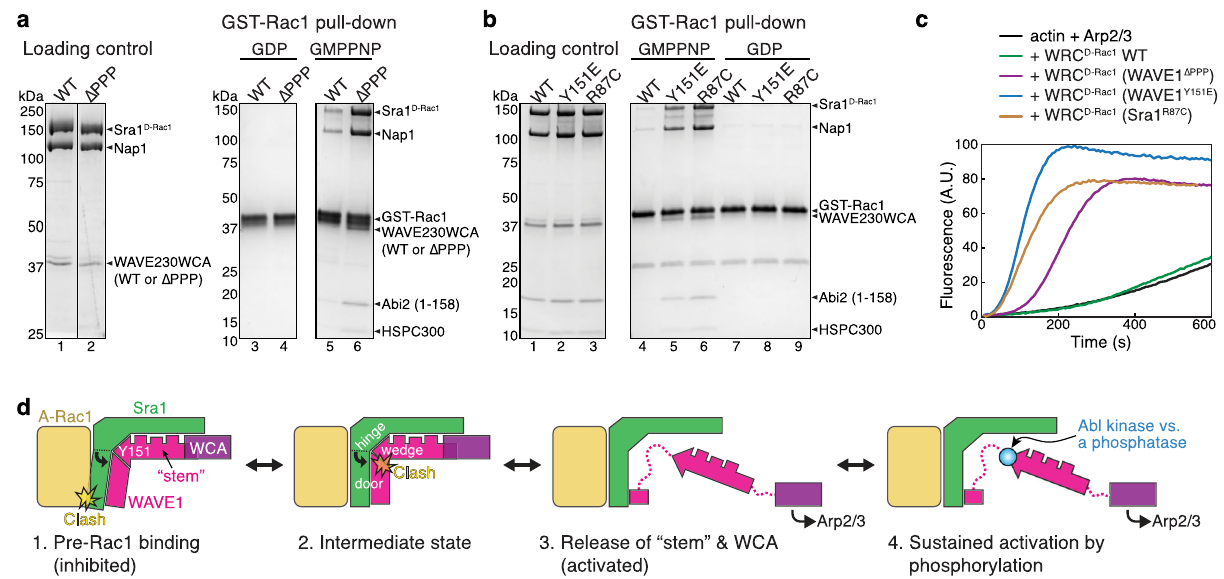
Fig. 5 | An allosteric competition model explains WRC activation by Rac1 binding to the A site. a , b Coomassie blue-stained SDS-PAGE gels showing GST- Rac1 P29S (loadedwithGDPorGMPPNP)pull-downofWRC D-Rac1 bearingtheindicated mutations: WAVE1 Δ PPP in (A) (replacing 131 PPPLNI 136 with a GSGSGS linker) and WAVE1 Y151E or Sra1 R87C in (B). c Pyrene-actin polymerization assays measuring the activities of WRC D-Rac1 used in (A-B). Reactions use the NMEH20GD buffer and contain 3.5 µ M actin (5% pyrene-labeled), 10nM Arp2/3 complex, and 100nM WRC D-Rac1 carrying indicated mutations. d A “ door wedge ” model describing the allosteric competition mechanism underlying WRC activation by Rac1 binding to